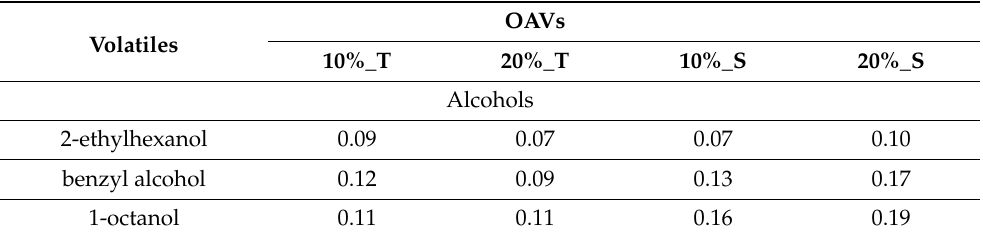
Table 5. Odor activity values (OAVs) of blackberry juice, citrus fiber and citrus fiber/blackberry gels after